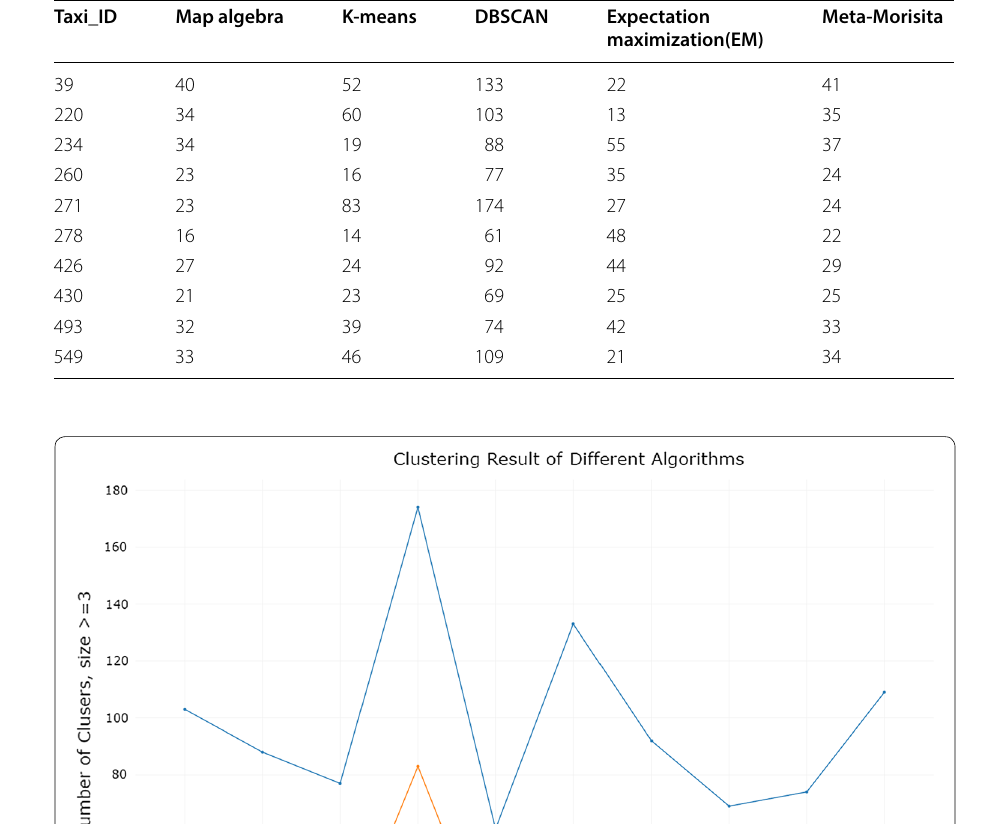
Table 3 Number of cluster identified in the sample, cluster size